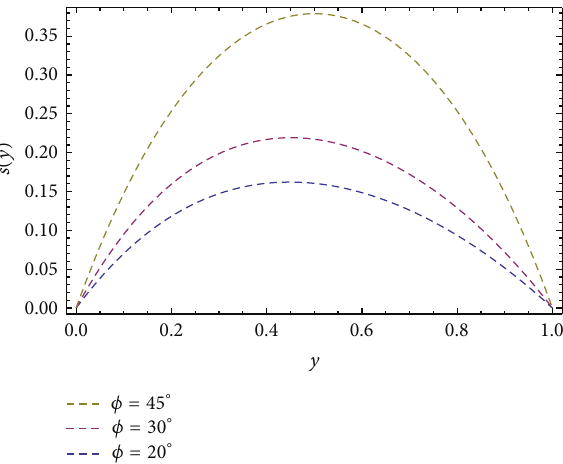
Figure 12: Velocity profile 𝑠(𝑦) for different values of 𝜙 , keeping 𝛼 = 1.0 , 𝛽 = 1.0 , 𝜕𝑃/𝜕𝑥 = −0.5 , and 𝜕𝑃/𝜕𝑧 = −0.5